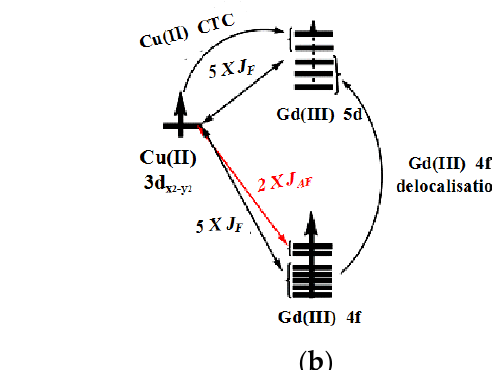
exchange interaction in this